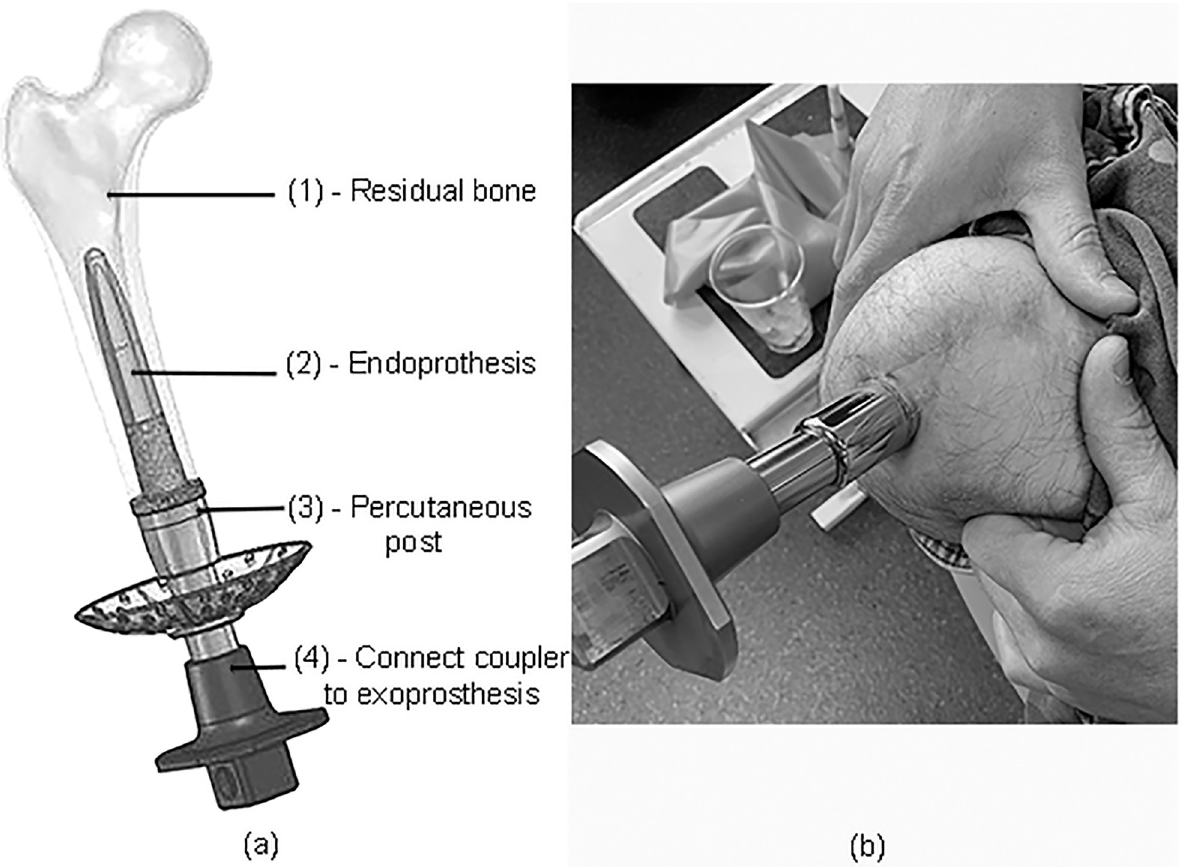
Fig 1. (a) —Diagrammatical representation of the Utah percutaneous osseointegrated device. An endoprosthesis (2) is inserted into the surgically prepared medullary canal of the residual femur (1), and a percutaneous post (3) is attached to the exoprosthesis using a Ferrier Coupler (4). (b)—A representative photograph shows the skin-implant interface of one study